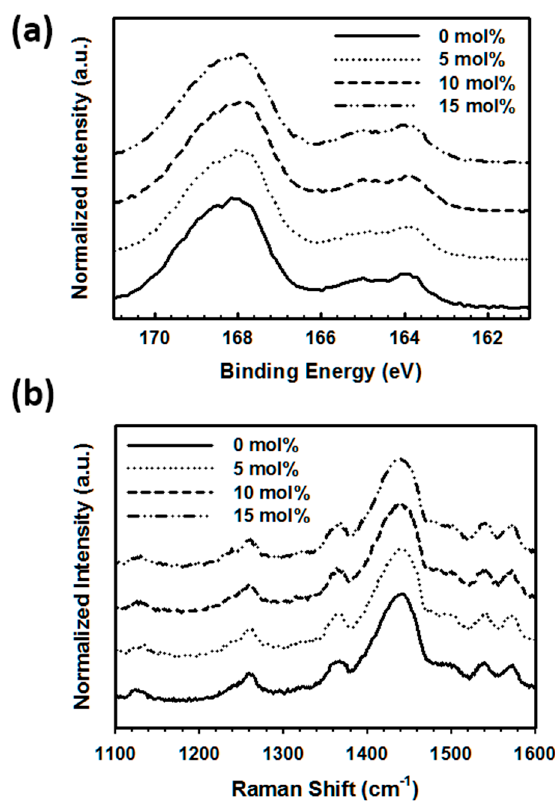
Figure 4. XPS spectra ( a ) and Raman shift spectra ( b ) of PEDOT:P(SS- co -VTMS).